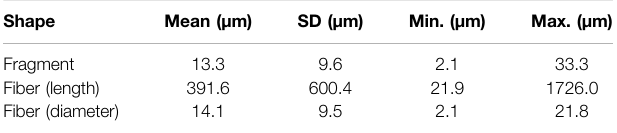
TABLE 2 | Average (±SD), minimum and maximum of size of ingested MPs found in the copepod Eurytemora af fi nis collected in the area “ La Bouille ” in the French Seine